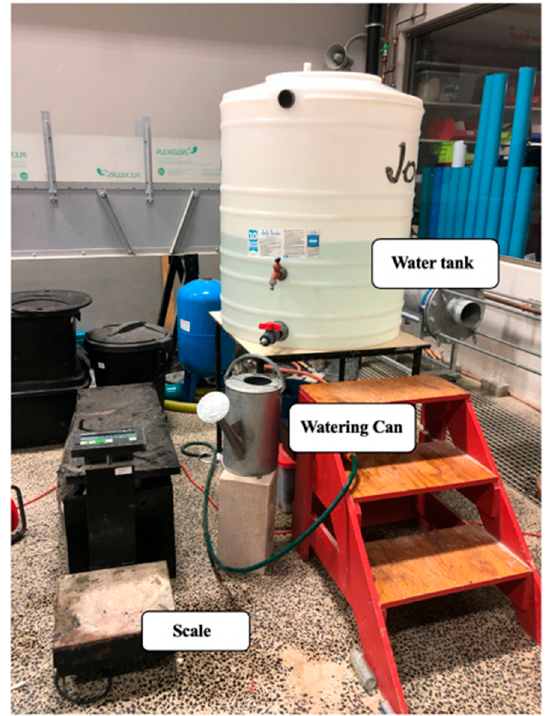
Figure 5. A 500-litre water tank and scale for measuring the mass of the liquid in the watering can.